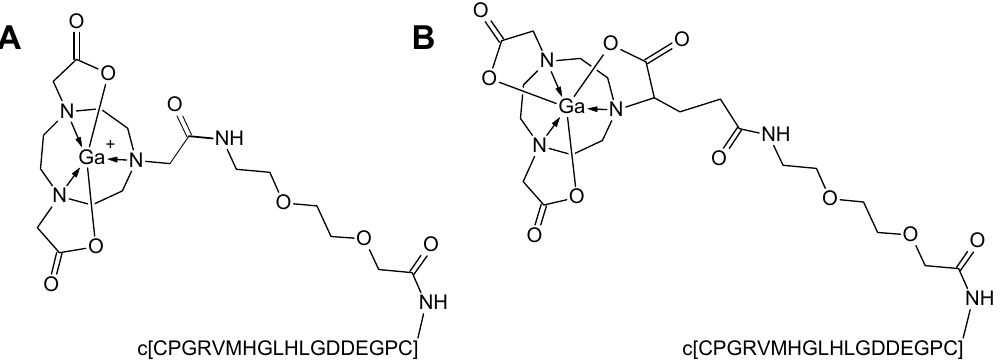
Figure 1. Chemical formulae of [ 68 Ga]Ga-NO2A-Col with a positively-charged complex moiety ( A ) and [ 68 Ga]Ga-NODAGA-Col with a neutral complex moiety ( B ), where c[CPGRVMHGLHLGDDEGPC] is a cyclic peptide, collagelin, coupled to the chelator moiety via an ethylene glycol linker (EG 2 ).